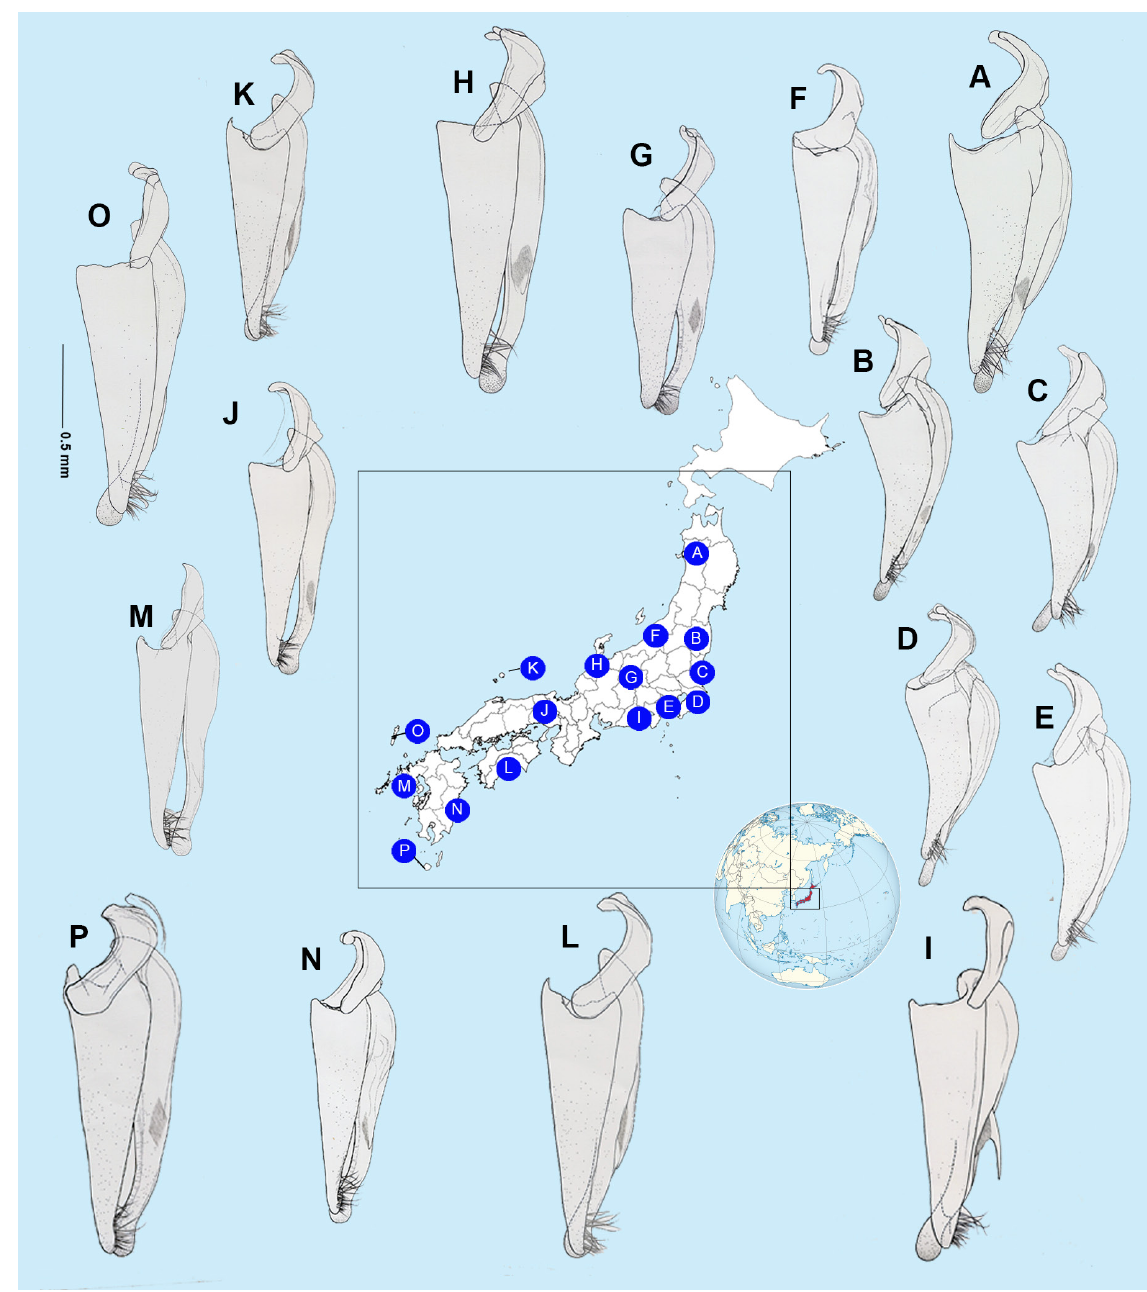
Fig. 12. Distribution of aedeagal patterns of Nipponoluciola cruciata (Motschulsky, 1854) gen. et comb. nov. in the Japanese islands; aedeagus right lateral view. Images by I. Kawashima. Map by W.F.A. Jusoh (Map of Japan using a base map obtained from Wikimedia Commons - Maximilian Dörrbecker and Connormah, CC BY-SA 3.0). A . Akita. B . Fukushima. C . Ibaraki. D . Chiba. E . Kanagawa. F . Niigata. G . Nagano. H . Ishikawa. I . Shizuoka. J . Hyogo. K . Oki Islands. L . Kochi. M . Nagasaki. N . Miyazaki. O . Tsushima Island. P . Yakushima